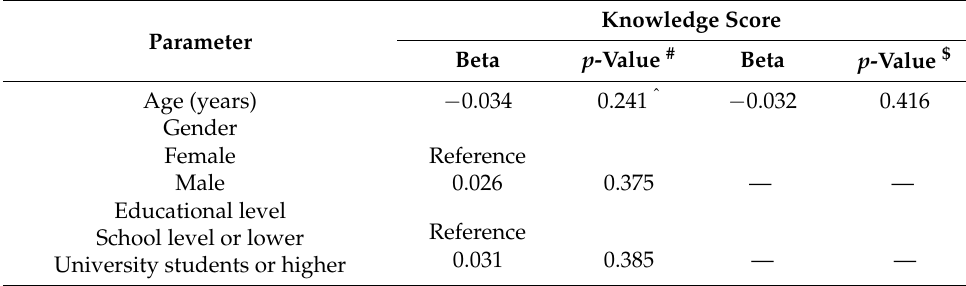
Table 5. Assessment of factors associated with participants’ knowledge about human